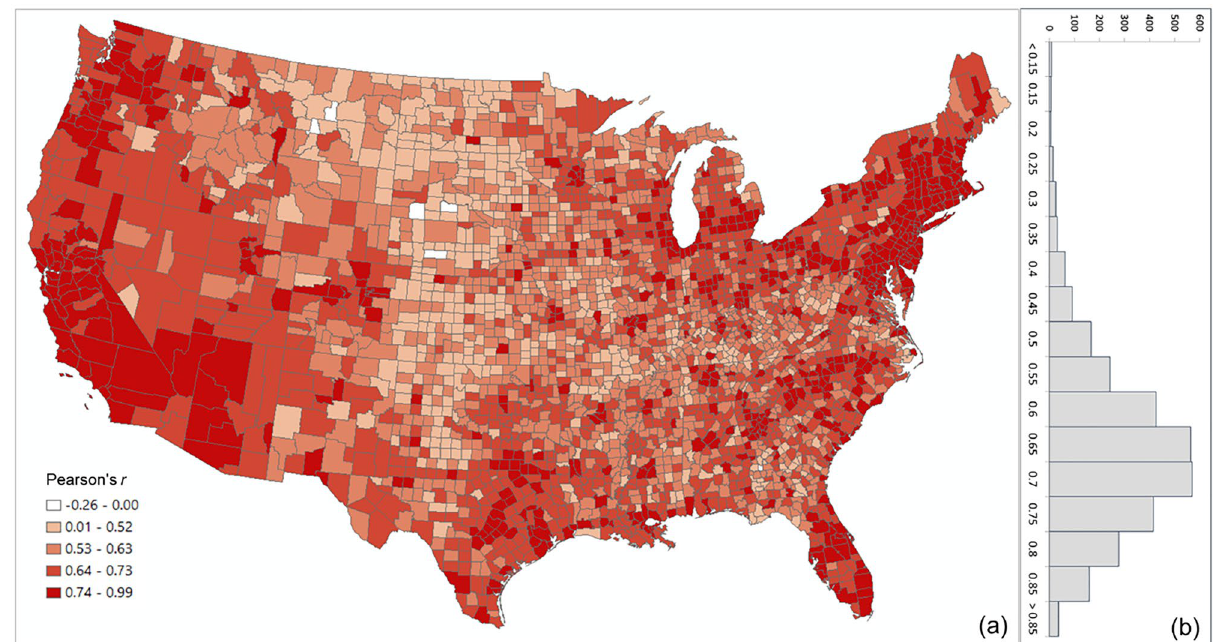
Figure 3. Distribution of the Pearson’s r between the log Twitter person-day movements and log SafeGraph person-day movements for all counties ( a ) Spatial distribution; ( b ) histogram. The map was generated using ArcMap version